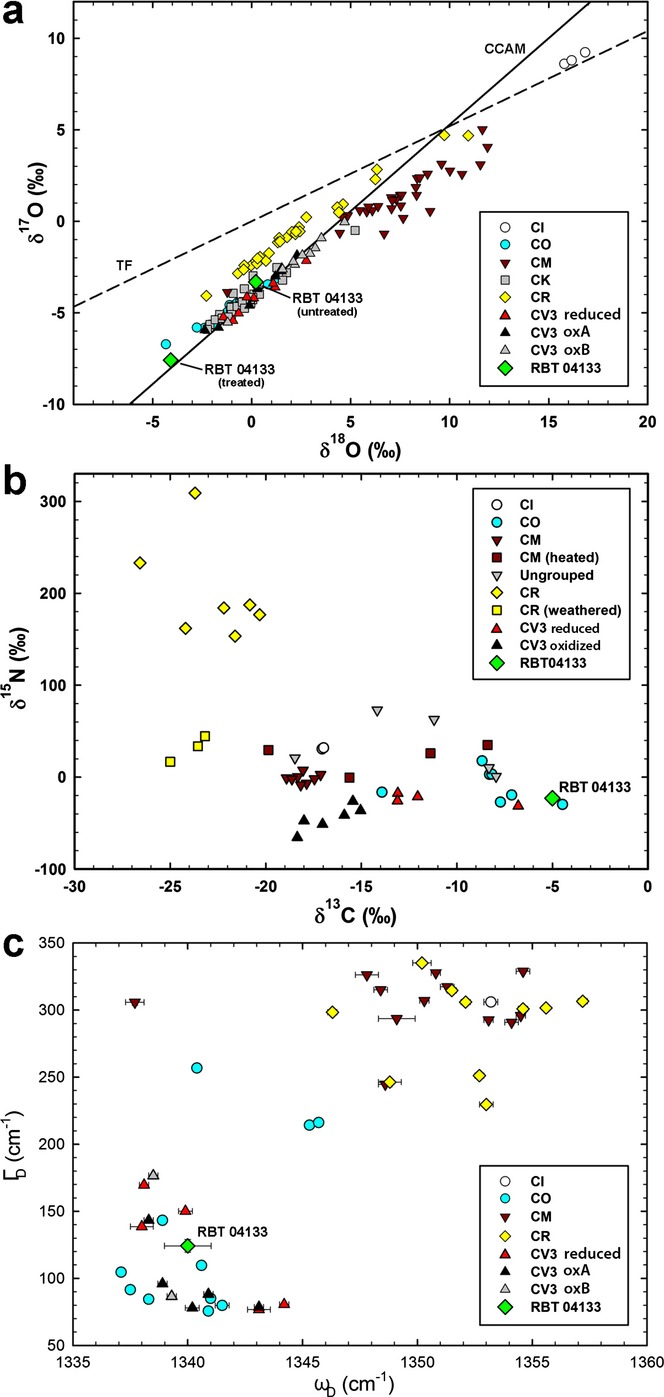
a) Whole-rock O-isotopic composition of RBT 04133,5 compared to CI, CO, CM, CK, CR, and CV chondrites; where TF = terrestrial fractionation line, and CCAM = carbonaceous chondrite anhydrous mineral line (δ17O = −4.17 + 0.945 × δ18O; Clayton et al. 1977). RBT 04133 plots with the CV3, CK, and CO chondrites, and away from the CR chondrites (which typically lie along their own mixing line above the CCAM line). All other data are from Weisberg et al. (1993), Clayton and Mayeda (1999), Martins et al. (2007), Choi et al. (2009), Greenwood et al. (2010), and Schrader et al. (2011). b) Carbon and N isotopic compositions of RBT 04133 IOM compared to those previously determined for IOM from other carbonaceous chondrites (Alexander et al. 2007). RBT 04133 is clearly not a CR chondrite (which exhibit isotopically heavier N and lighter C), but agrees with both CO and CV3red chondrites. c) Raman D-band parameters (ωD = position of D band, and ΓD = full width at half maximum) for RBT 04133 IOM compared to IOM from other carbonaceous chondrites (Busemann et al. 2007). IOM from meteorites appear to cluster together within chondrite classes. RBT 04133 IOM clearly plots away from the CR chondrites, and within the same region as the CV and CO chondrites.